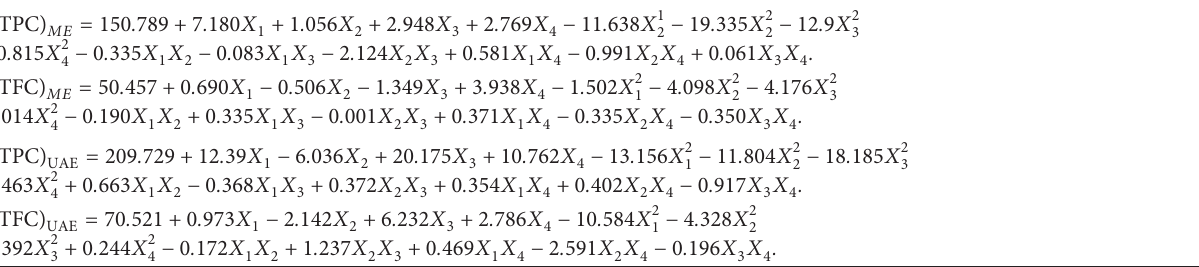
Figure 2: Effect of extraction time (a), temperature (b), ratio s/m (c), and ethanol (%) (d) on total phenol and flavonoid contents from Eucalyptus marginata L. leaves using the ultrasound-assisted extraction Table 3: The responses in TPC and TFC for the two extraction methods.